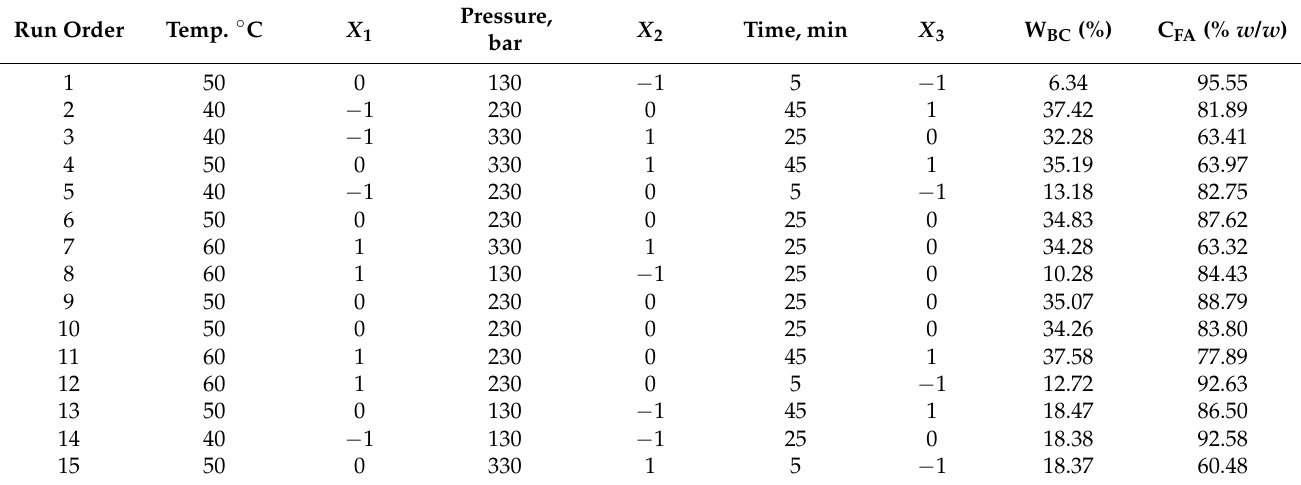
Table 4. Extraction parameters in individual experiments and the results of extraction of black cumin seeds with supercritical carbon dioxide on the ASFE MV-10 Waters